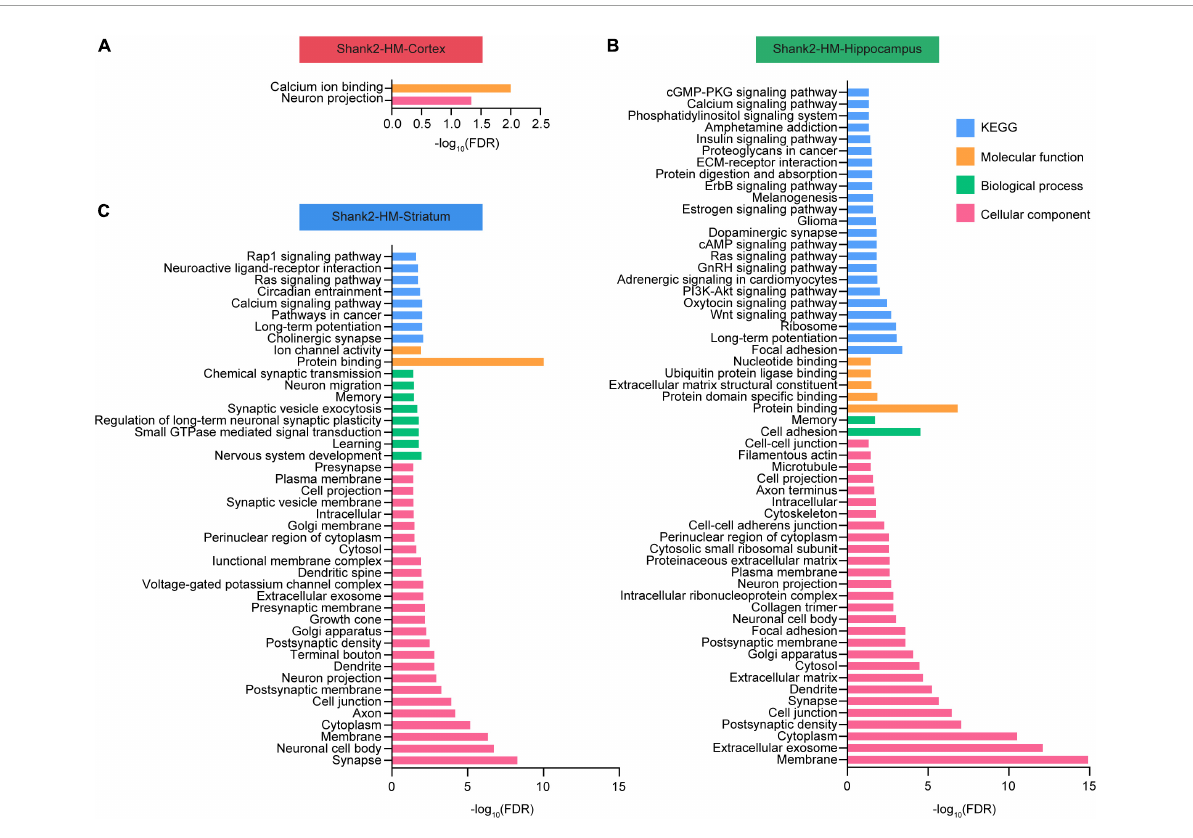
FIGURE2 Database for annotation, visualization, and integrated discovery (DAVID) analysis of Shank2-heterozygous (HT) and Shank2-homozygous (HM) differentially expressed genes (DEGs). (A–C) DEGs in the cortical, hippocampal, and striatal transcripts from Shank2-HT and Shank2-HM mice [13 weeks; male; n = 5 mice wild-type (WT), 5 (HT), and 5 (HM)] were subjected to DAVID analysis for associations with gene ontology (GO) terms in the molecular function (MF), biological process (BP), cellular component, and KEGG domains. The low GO scores for the cortical DEGs may reflect the small number of these DEGs. FDR, false discovery